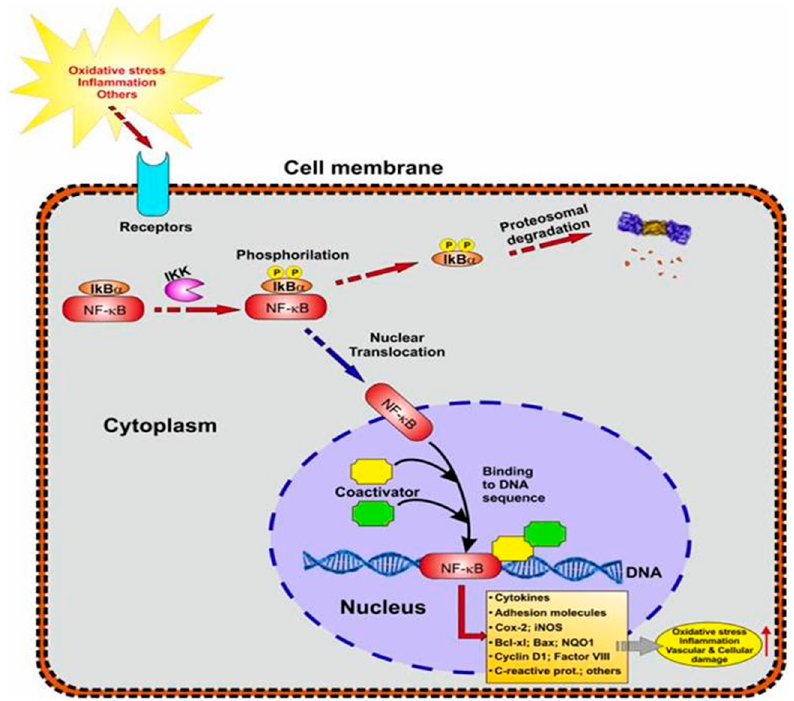
Figure 1. NF-kB regulation under cellular stress conditions: NF-kB is a transcription factor that modulates immune function, inflammation, cellular growth, and apoptosis. OS induces activation of I κβ kinase (IKK), leading to the phosphorylation of NF-kB inhibitor, resulting in polyubiquitination- mediated proteasomal degradation of I κβ , releasing NF-kB, which migrates into the nucleus, binds to its corresponding DNA responsive elements and induces the transcription of pro-inflammatory mediators [48].